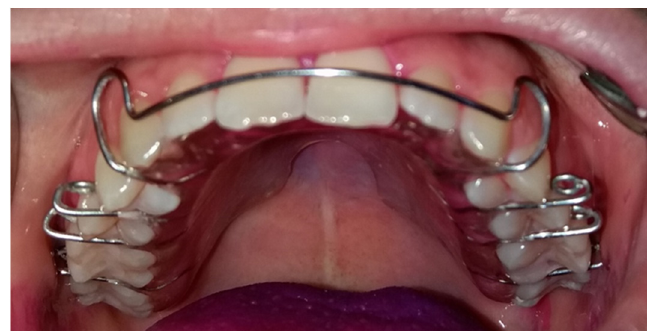
Figure 1. Hawley retainer used in the study.